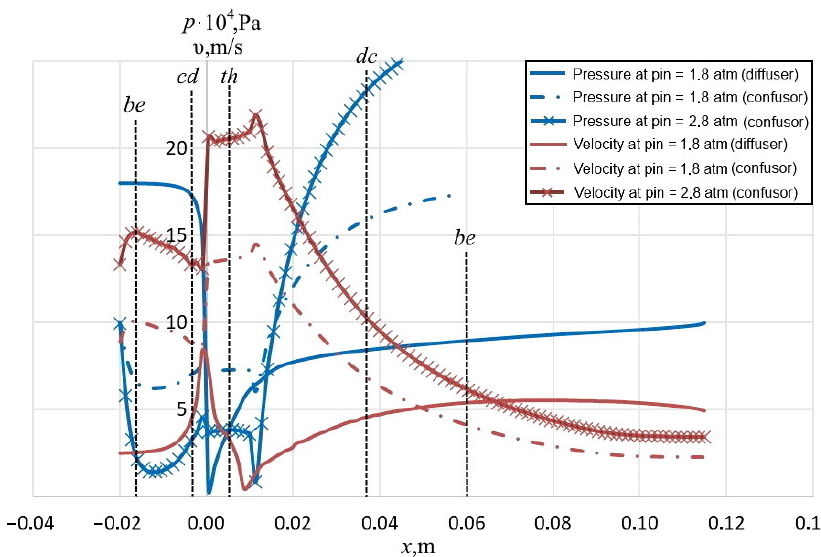
Figure 10. Numerical and experimental results. Cylindrical nozzle. ( a , b )—inlet pressure 2.5 atm, ( c , d )—inlet pressure 2.8 atm.